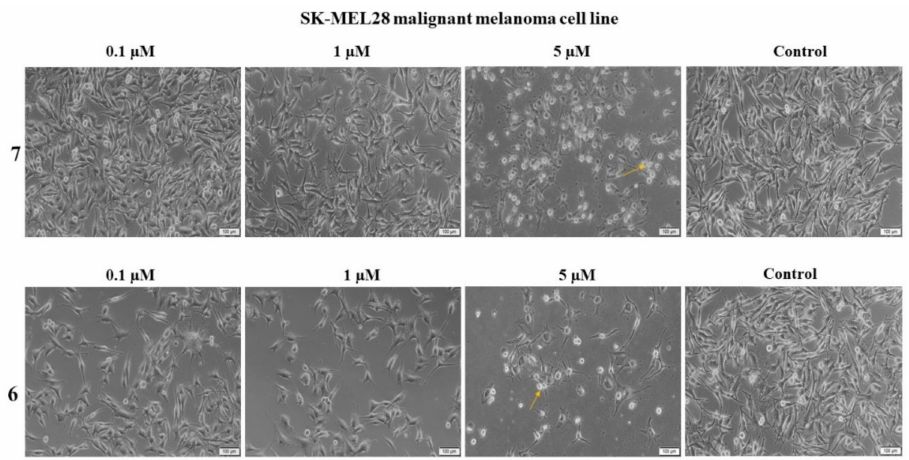
Figure 11. Morphological aspect of the SK-Mel-28 cells after the treatment with compounds 6 and 7 (0.1, 1, and 5 µ M) for 24 h. The arrows indicate the round and detached cells noticed following the treatment with compounds 6 and 7 . The scale bars represent 100 µ